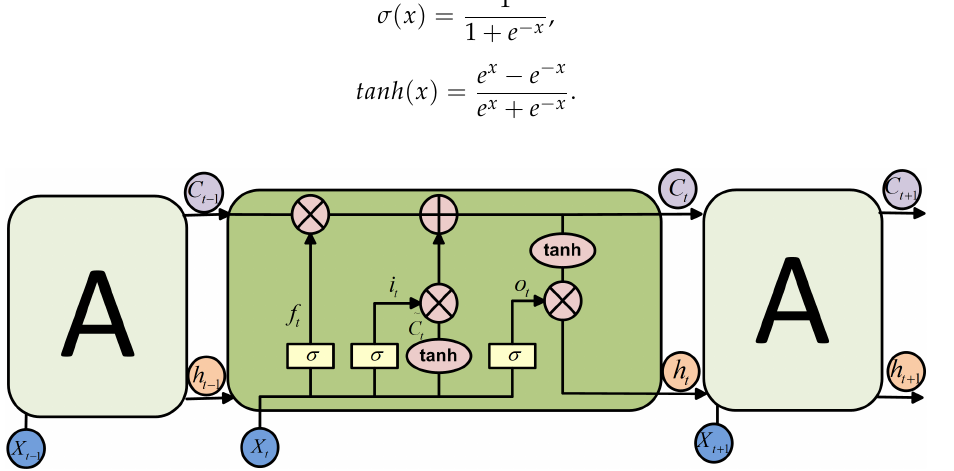
Figure 2. The structure of